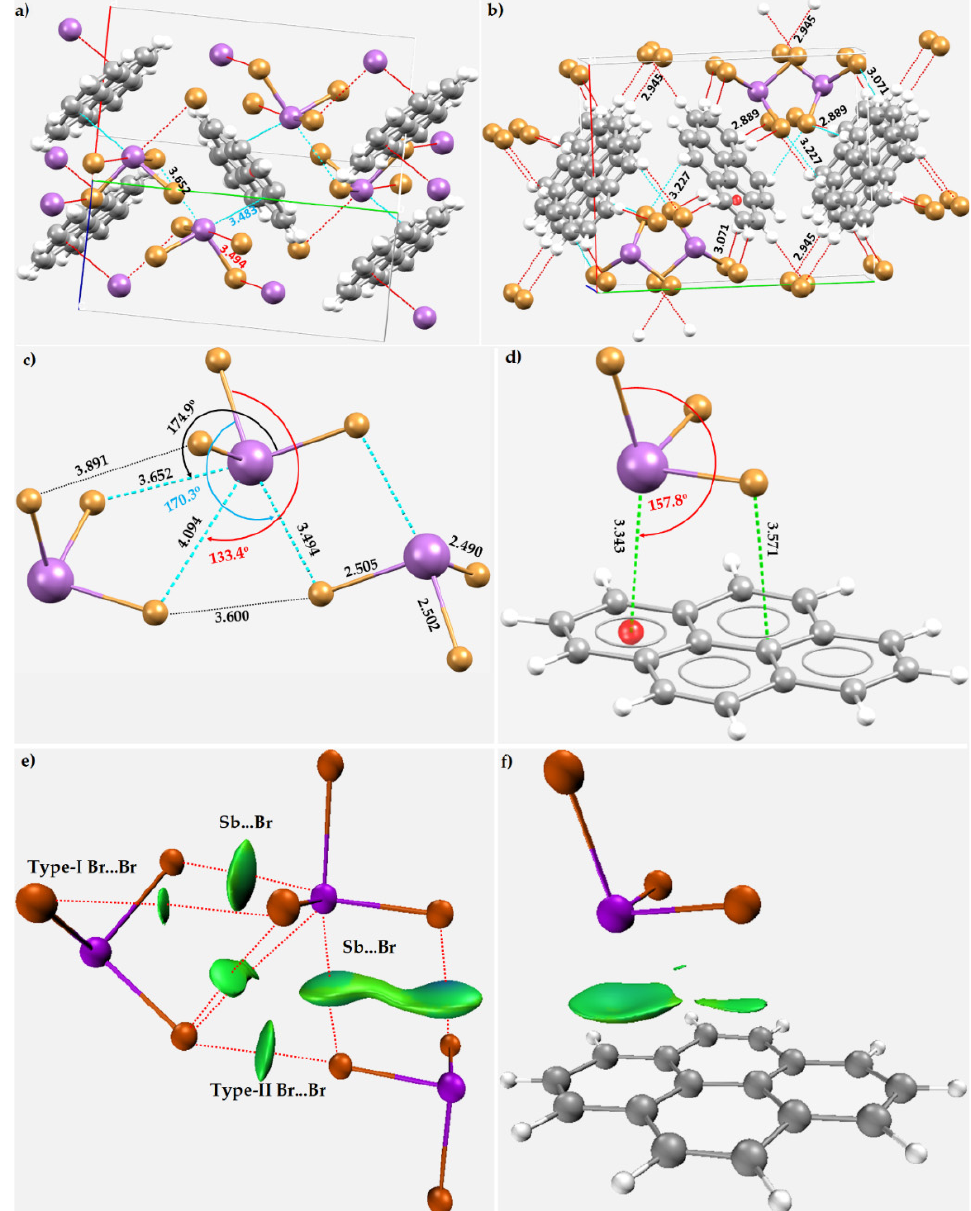
Figure 21. The topology of ( a ) Sb···Br and Sb··· π pnictogen bonding and ( b ) hydrogen bonding in the unit-cell of the crystal of SbBr 3 (CSD ref. code PYRABR). ( b ) The nature of Br···Br halogen-halogen bonding and Sb···Br pnictogen bonding between the SbBr 3 units in the crystal. ( c ) The nature of Sb··· π pnictogen bonding between pyrene and SbBr 3 in the crystal. ( e , f ) The IGM- δ g based isosurface topologies between the molecular entities shown in ( c ) and ( d ), respectively. Selected bond distances and bond angles are in Å and degree, respectively. Atoms are shown as small spheres and bonds as lines in atom color, whereas the intermolecular interactions are represented by dotted lines. Atom color: Sb—purple; Br—dark-red; C—gray; H—white-gray.